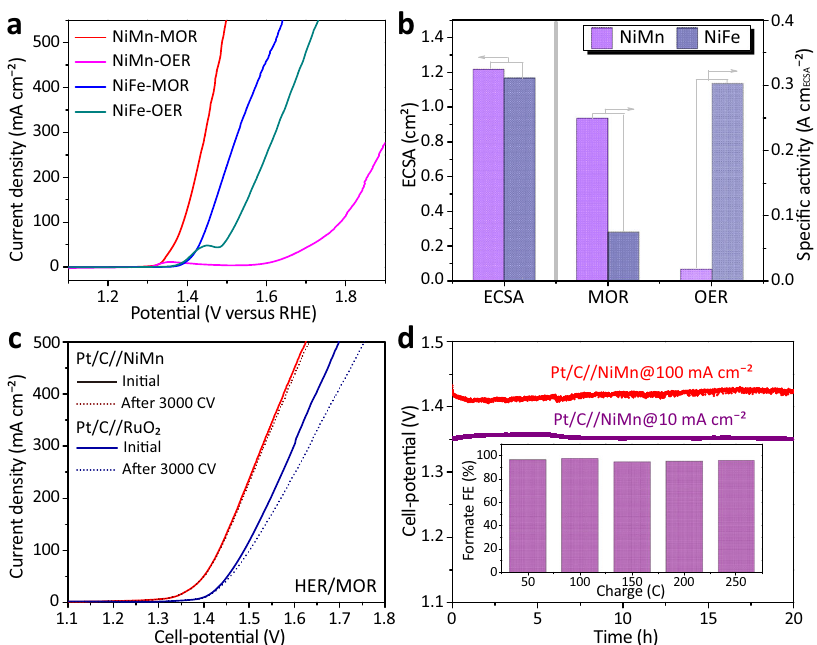
Fig. 2 | Electrocatalytic performance of the catalysts. a IR-corrected LSV curves of NiMn and NiFe-LDHs both recorded in 1M KOH without and with 3M CH 3 OH. b ECSAnormalizedspeci fi cactivitiesofNiMnandNiFe-LDHsforMOR(at1.45V RHE ) andOER(at1.65V RHE ). c CellLSVcurves(noiRcorrection)ofHER/MORelectrolysis